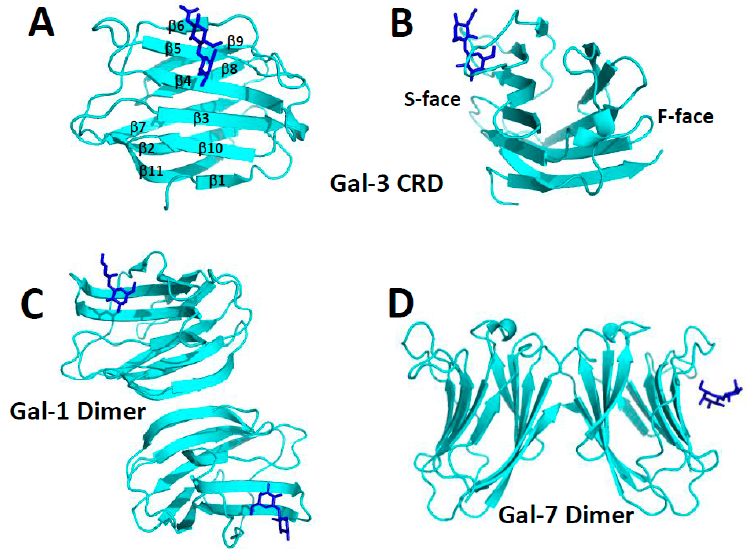
Figure 1. Galectin oligomer states. ( A , B ) Gal ‐ 3 carbohydrate recognition domain (CRD) (Protein Data Bank (PDB) access code 1A3K) as a monomer illustrating the β‐ sandwich fold common to all galectins. The 11 β‐ strands found within the CRD β‐ sandwich are labeled β 1 to β 11 in A , and the S ‐ and F ‐ faces of the CRD are identified in B . ( C , D ) Two prototype galectin dimers are shown. The CRD of the Gal ‐ 1 “terminal” dimer (PDB access code 1GZW) is shown in C , and the “symmetric sandwich” dimer of human Gal ‐ 7 (PDB access code 1BKZ) is shown in D . The carbohydrate binding sites in all structures are indicated by the lactose molecules shown in blue with a ball ‐ and ‐ stick structure.